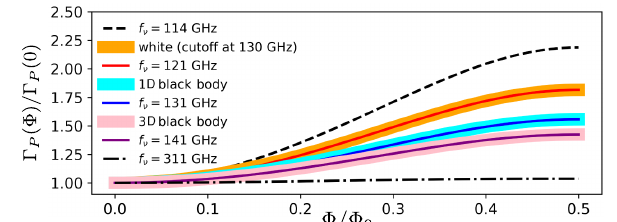
FIG. 6. The calculated relative flux dependence of (cid:4) induced by various absorbed photon spectral densities. The thin lines cor- respond to (cid:4) P calculated for individual photon frequencies as described in Appendix A, with lower photon energies resulting in a larger increase in (cid:4) P ((cid:5))/(cid:4) P ( 0 ) . The thick lines correspond to (cid:4) P calculated for the following spectral densities: a white spectrum with a cutoff at 2.5 ¯ (cid:2) ≈ 130 GHz (orange), a one- dimensional black body at 1 K (cyan), and a 3D black body at 1 K (pink). Each of these spectral densities results in (cid:4) P ((cid:5))/(cid:4) P ( 0 ) that can be matched by PAPS induced by individual photon frequencies (thin colored